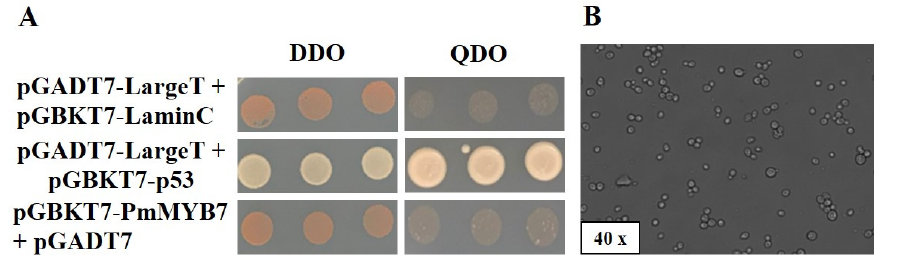
Figure 5. Autoactivation and toxicity analysis of pGBKT7-PmMYB7 and library screening. ( A ) AuTable 7. p53 + pGADT7-largeT was cotransformed as a positive control, and pGBKT7-laminC +